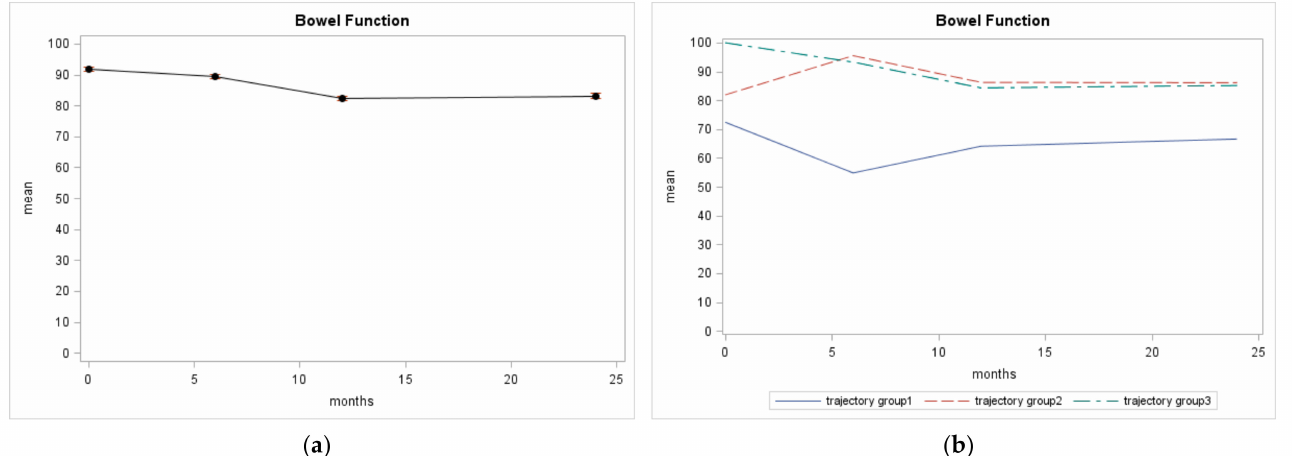
Figure 2. Italian- University of California Los Angeles-Prostate Cancer Index (Italian-UCLA-PCI) BF scores from Pros-IT participants across 4 evaluations; ( a ) Overall mean and standard error; ( b ) BF trajectory patterns